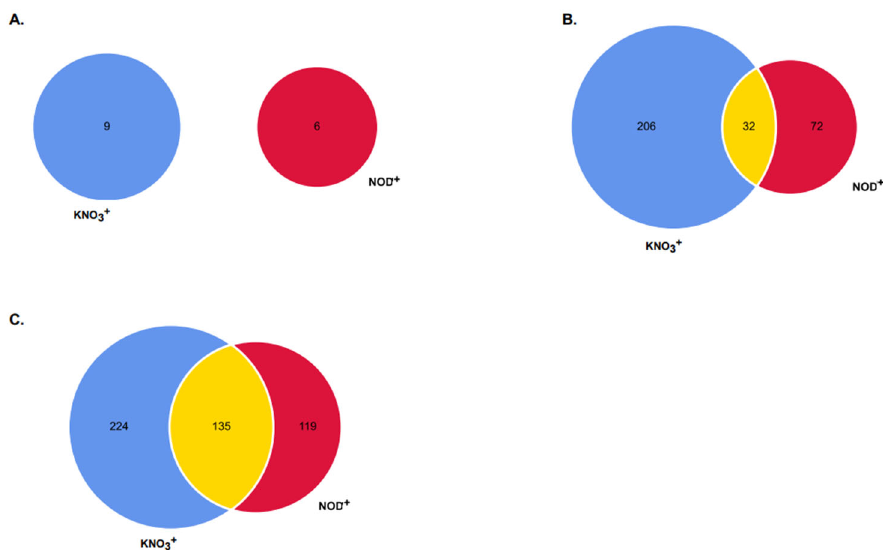
Figure 3. Specific and overlapping genes between Casuarina glauca plants supplied with KNO 3 (KNO 3+ ) or nodulated by nitrogen ‐ fixing Frankia casuarinae Thr (NOD + ). Significant differentially expressed genes (DEGs), with a False Discovery Rate (FDR) < 0.05, were detected between the con ‐ trol (0 mM NaCl) and salinity ‐ exposed plants: ( A ) 200 mM NaCl; ( B ) 400 mM NaCl; ( C ) 600 mM